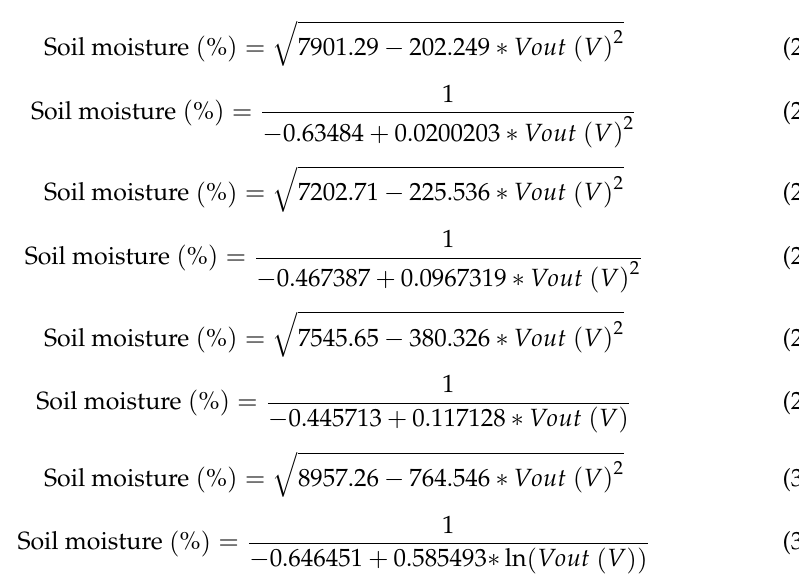
Figure 29. Vout NP2, 500 kHz one model (I), Equation (21).